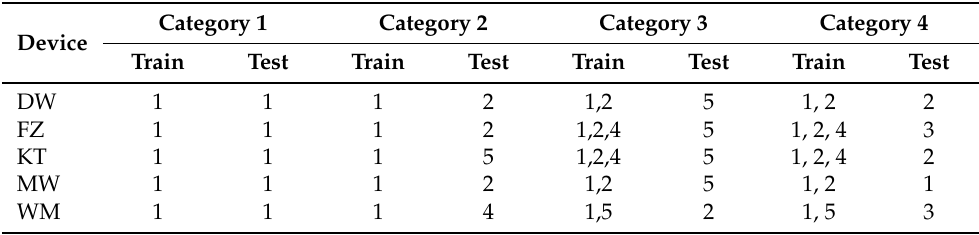
Table 3. Buildings used for train and test. In categories 1–3, UK-DALE was used for both training and testing. In Category 4, UK-DALE was used only for training. For testing DW and KT REFIT was used, whereas REDD was used for testing FZ, MW and